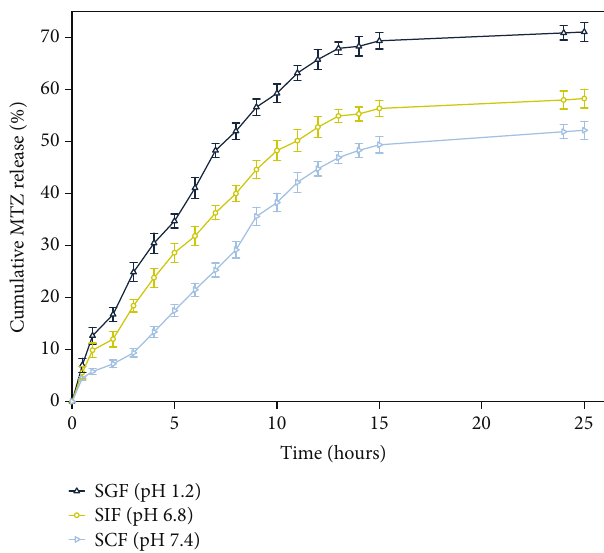
Figure 10: Cumulative MTZ release from the hydrogel MTZ-H2- G3 in SGF, SIF, and SGF at 37 °